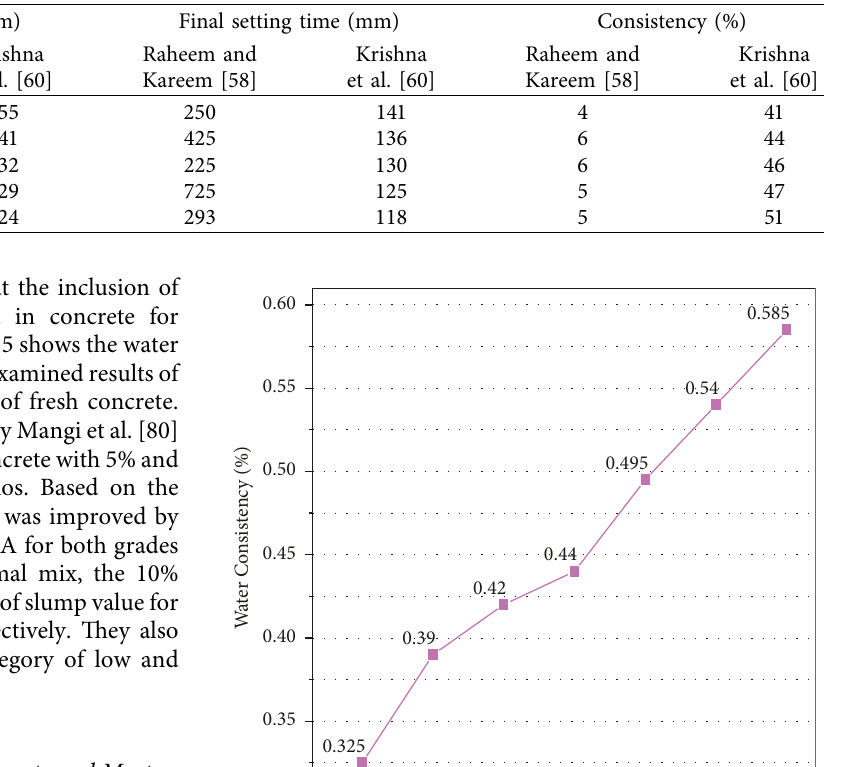
Table 10: The effects of RHA in workability of concrete.